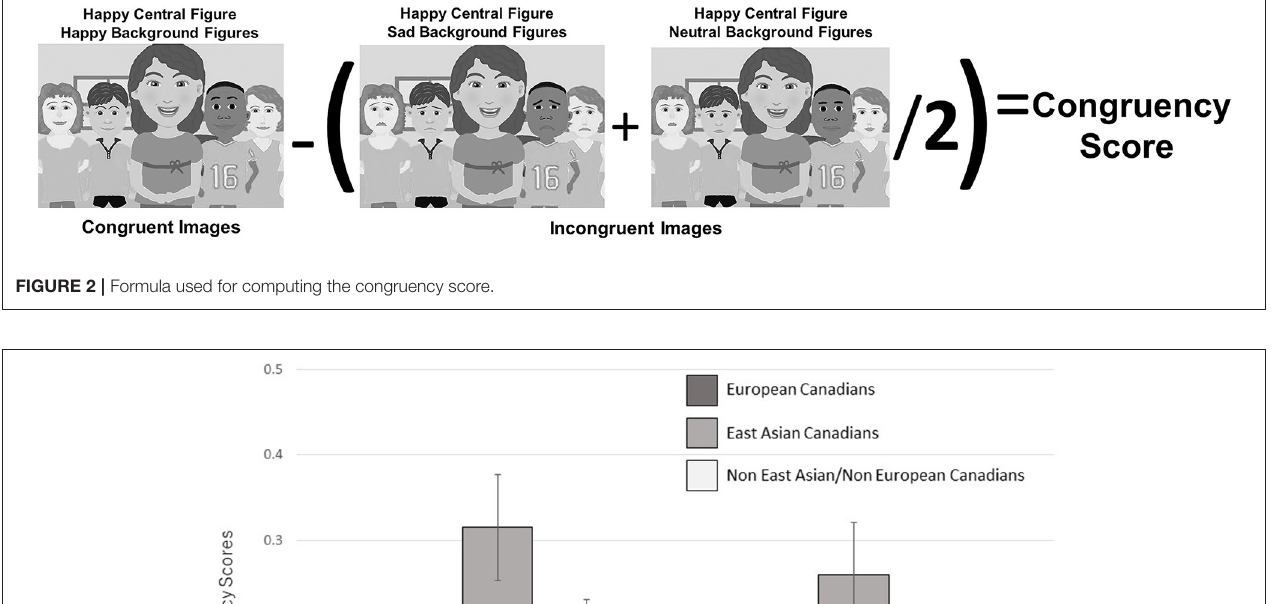
p = 0.014, Cohen’s d = 0.36. Also, there was